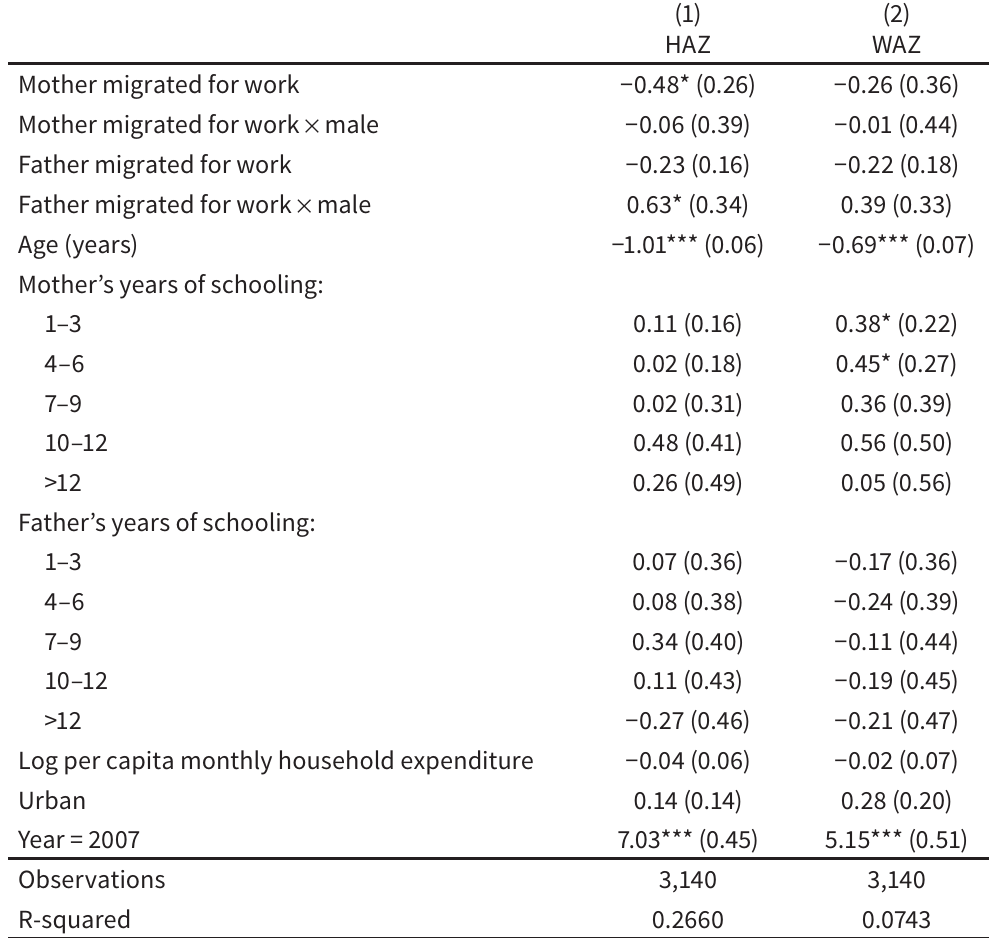
Do parental migration coefficients vary by sex of